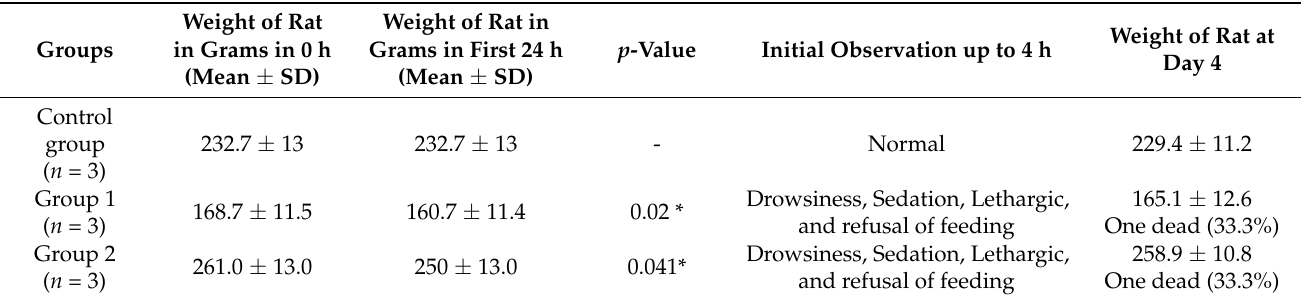
Table 3. Acute toxicity and weight changes study.